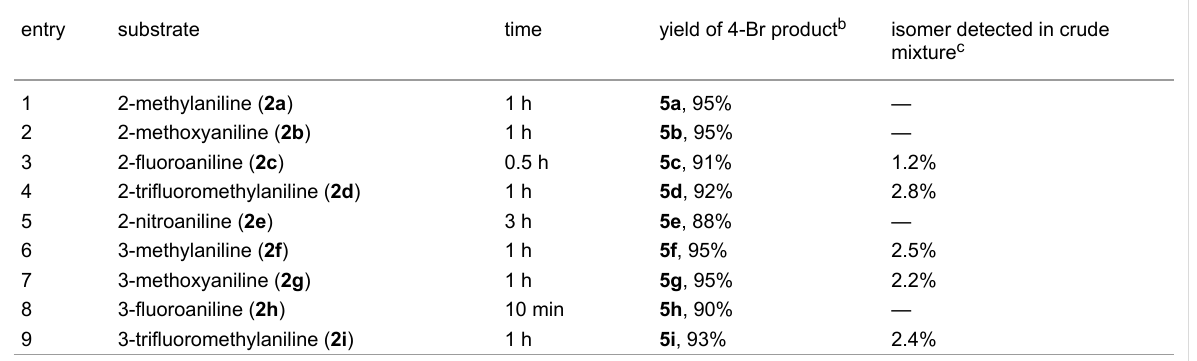
Table 3: Bromination of aniline analogues (100 mmol scale) using CuBr 2 in 1-hexyl-3-methylimidazolium bromide. a